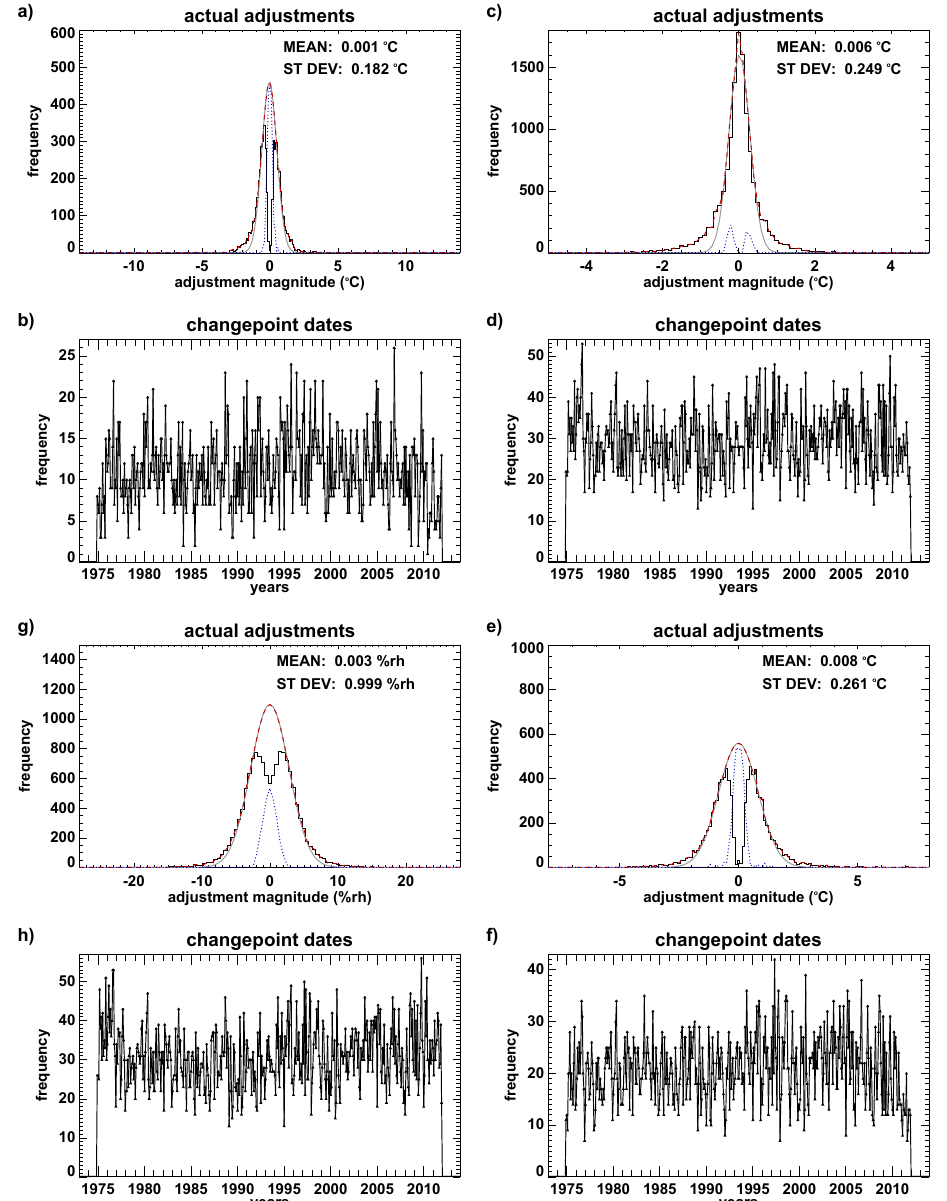
Figure 5. Adjustment sizes and locations applied by PHA (a, b, e, f) and ID PHA (c, d, g, h) to all monthly mean station time series combined. (a, c, e, g) Distribution of adjustment size (black line) with a Gaussian fit (grey line), a best-fit merged line taking the larger wings and Gaussian fit over the missing middle (red dashed line) and the difference between the best-fit line and actual distribution (blue dotted line) for temperature, dew point depression and relative humidity, respectively. The mean and standard deviation of the differences are shown. b,d,f,h) Distribution of adjustments over time for temperature (a, b, c, d) , dew point depression (e, f) and relative humidity (g, h) ,